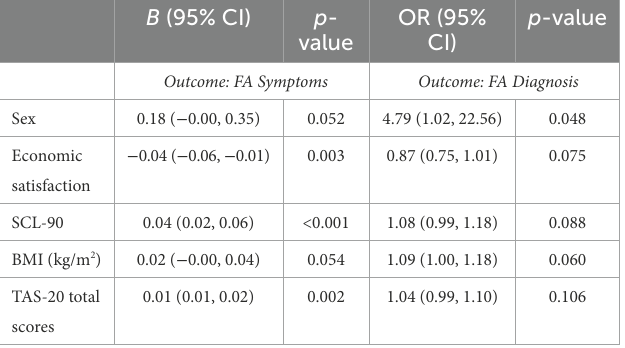
TABLE 4 Associations between alexithymia and food addiction (linear regression for the symptoms and logistic regression for the “diagnosis”), controlling for selected covariates.